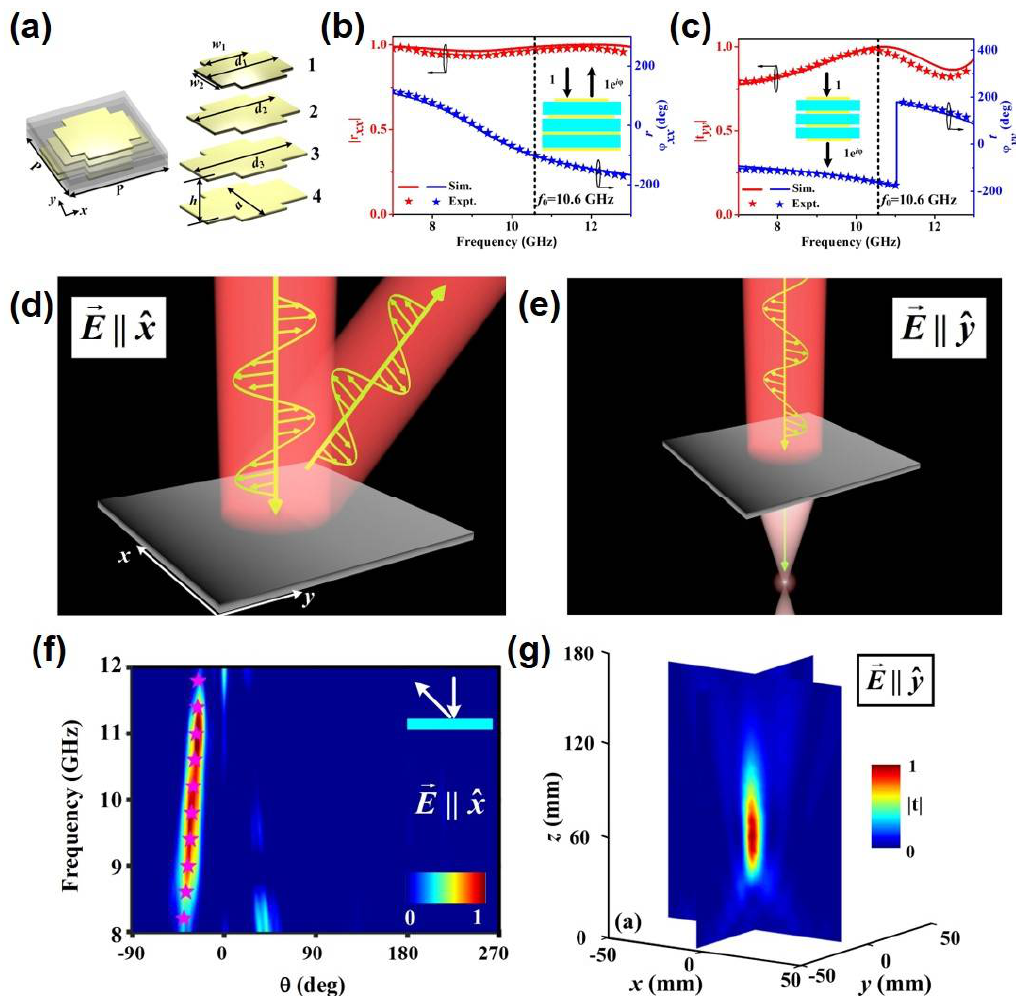
Figure 7. ( a ) Schematics of a 4-layer meta-atom composed by four metallic layers separated by three spacers. Measured and Finite-Difference Time-Domain (FDTD) simulated amplitude-phase spectra of reflection ( b ) and transmission ( c ) for a periodic metasurface made by the meta-atom given in ( a ), under excitations with different polarizations. Schematics of a bi-functional metasurface which behaves as ( d ) a reflective beam deflector and ( e ) a transmissive lens under excitations of x - and y -polarized waves, respectively. Measured scattered field intensity versus frequency and detecting angle at reflection sides ( f ) of the metasurface shined by x -polarized microwaves and electric field distributions on both x o z and y o z planes at transmission sides ( g ) of the metasurface shined by y -polarized microwaves. Reproduced from [97] with permission.